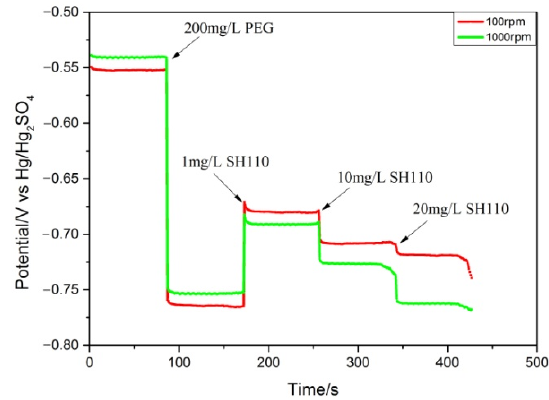
Figure 4. Galvanostatic measurements with 200 mg/L PEG10000 and 1~20 mg/L SH110, and the rotating speed 1000 rpm or 100 rpm. The plating solution was composed of 70 g/L CuSO 4 · 5H 2 O, 200 g/L sulfuric acid, 60 mg/L Cl − .